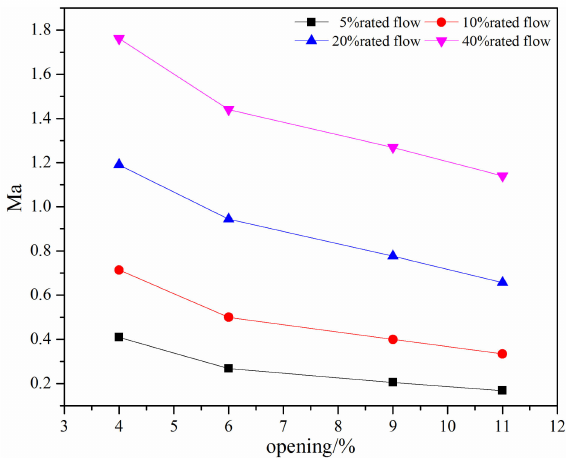
Figure 6. The maximum Mach number under di ff erent mass flow rates at small valve